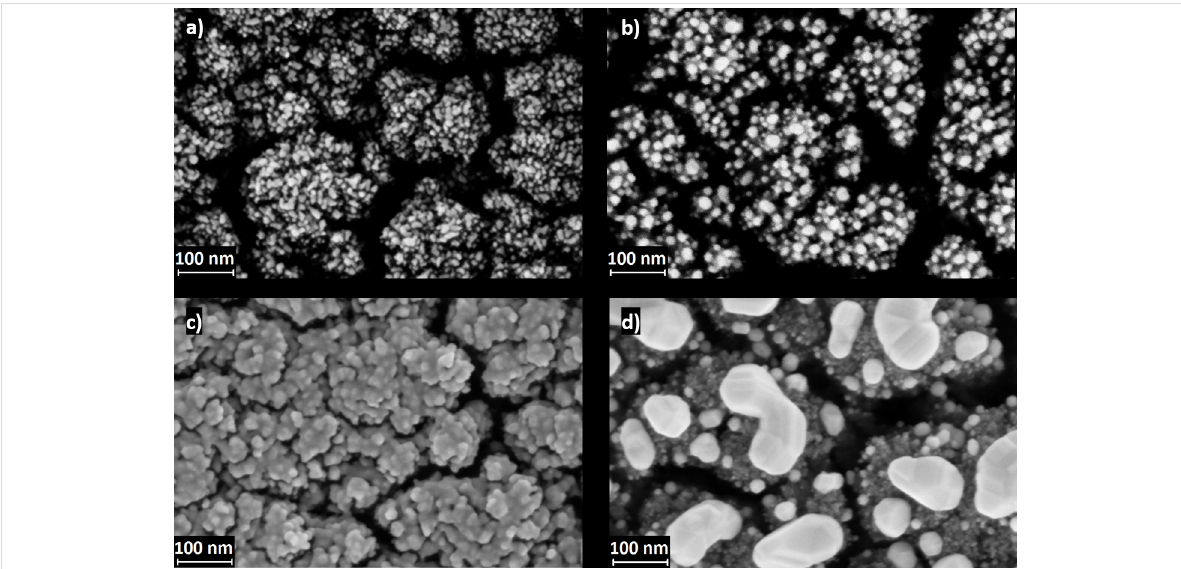
Figure 2: SEM top-view images showing 12 Pa TiO 2 samples with 3 nm of evaporated Au before (a) and after (b) annealing. Panels (c) and (d) show 12 Pa TiO 2 samples with 15 nm of evaporated Au, respectively, before (Au continuous layer) and after annealing (completely formed NPs).